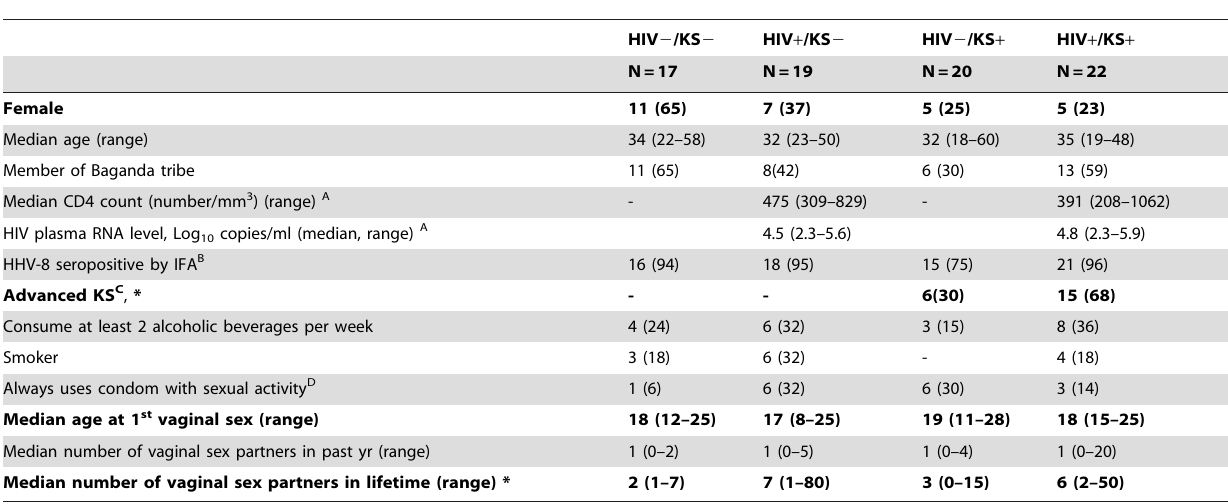
Table 1. Demographic, clinical and behavioral characteristics of